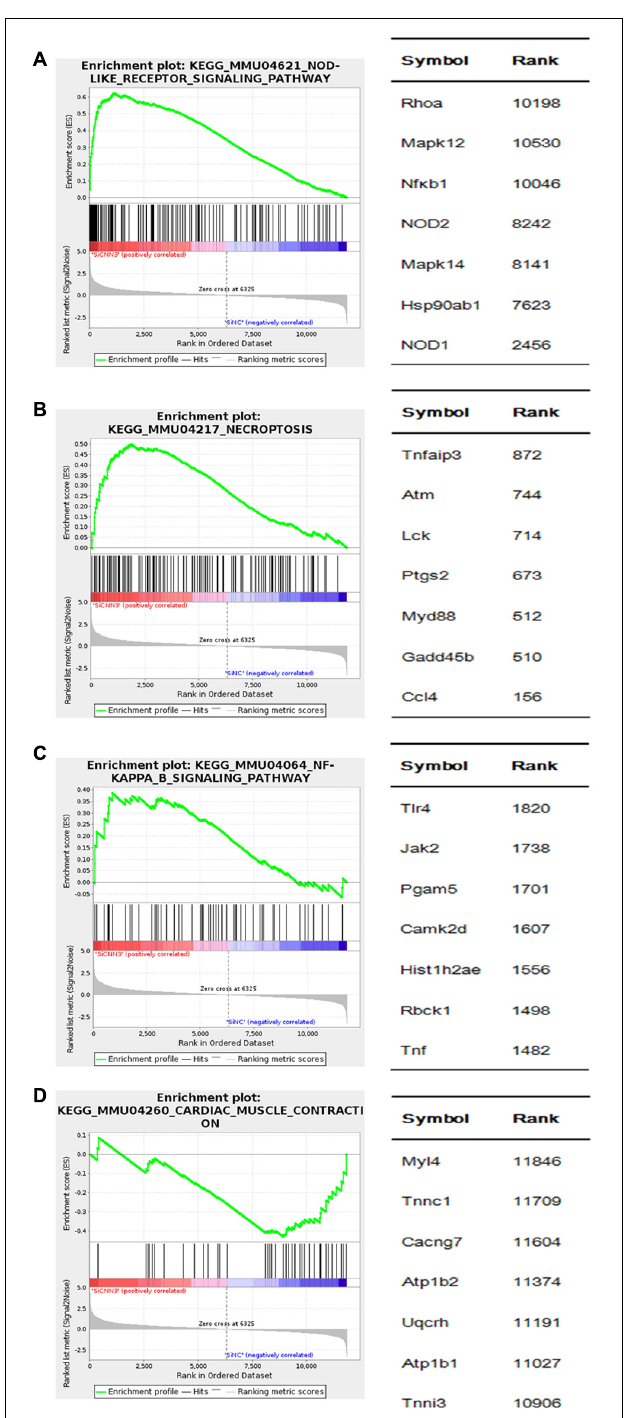
FIGURE 8 | GSEA of differentially expressed genes in CNN3 knockdown C2C12 cells. GSEA results are shown. The upregulated genes in (A) nucleotide-binding oligomerization domain (NOD)-like receptor signaling pathway [normalized enrichment score (NES) = 1.869; P = 0.000], (B) necroptosis signaling pathway (NES = 1.698; P = 0.000), (C) NF- κ B signaling pathway (NES = 1.428; P = 0.000), and the downregulated genes in (D) cardiac muscle contraction signaling pathway (NES = -1.349; P =